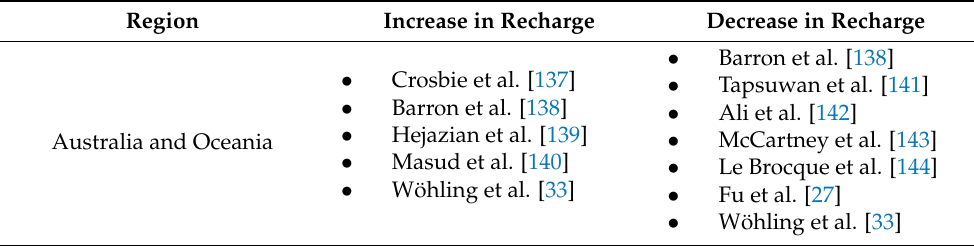
Table 7. Scientific production identified for Australia and